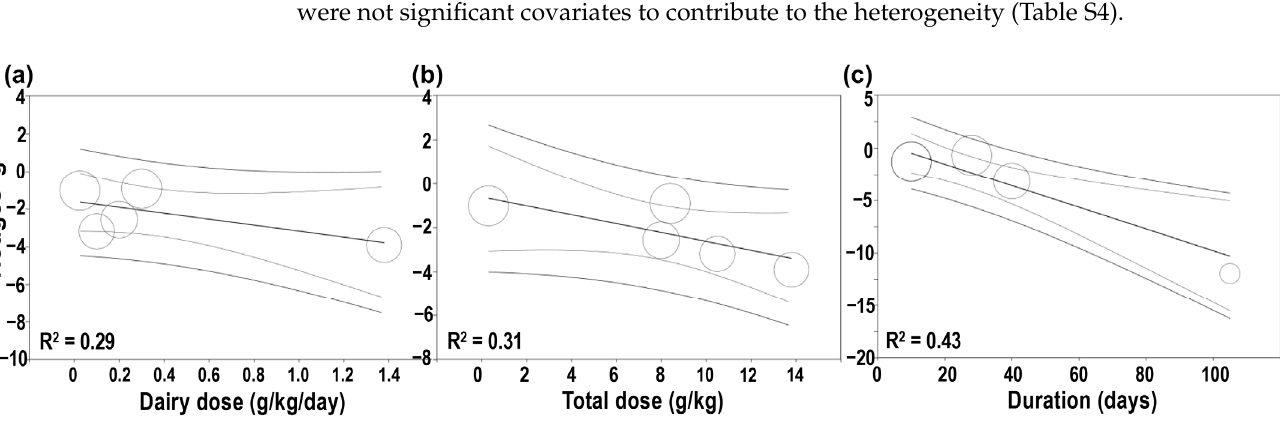
Figure 6. Meta-regression analyses for Hedges’ g of serum/plasma TG levels and daily (g/kg/day) ( a ) and total doses (g/kg) ( b ) of A. lappa extracts in chemically induced DM models. That for Hedges’ g of serum/plasma TC levels and duration (days) ( c ) in chemically induced DM models.